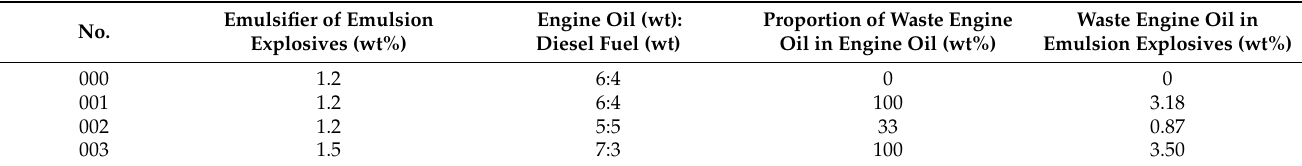
Table 3. The formulations of emulsion explosive mixed with waste engine